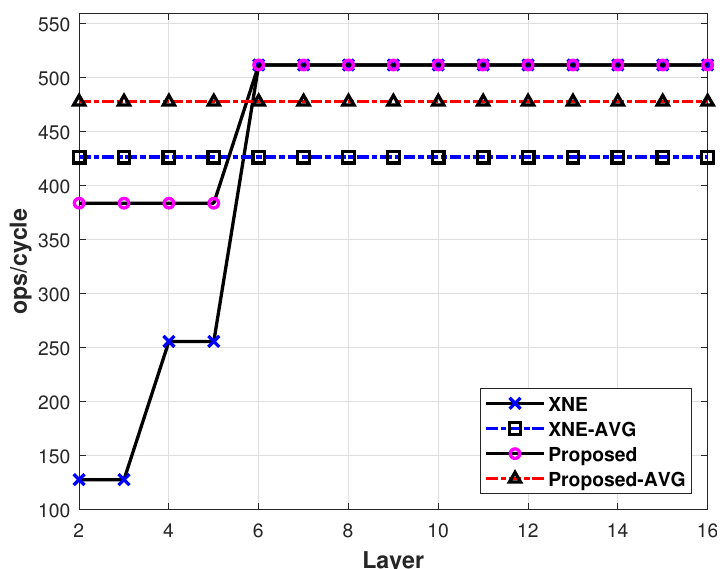
Figure 8. Comparison results of throughput performance for VGG-16. XNE, XNOR neural engine.